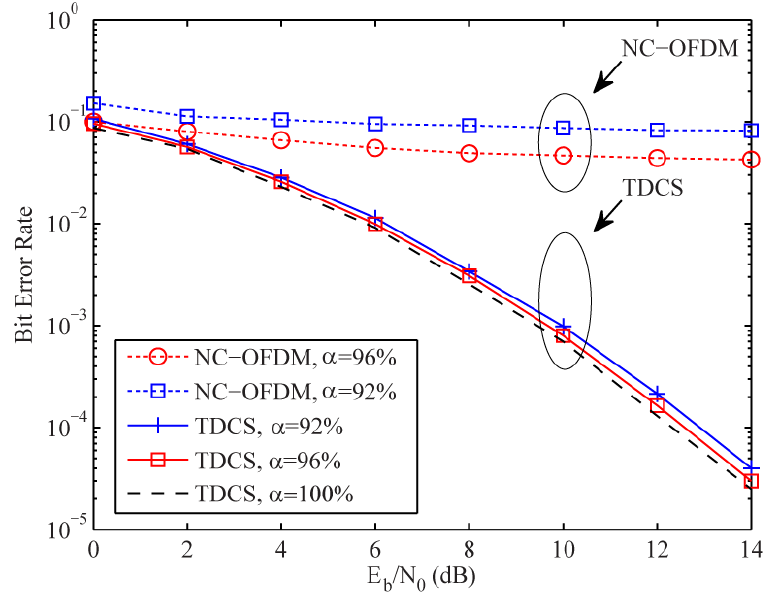
Figure 11. BER comparison of the TDCS and NC-OFDM.